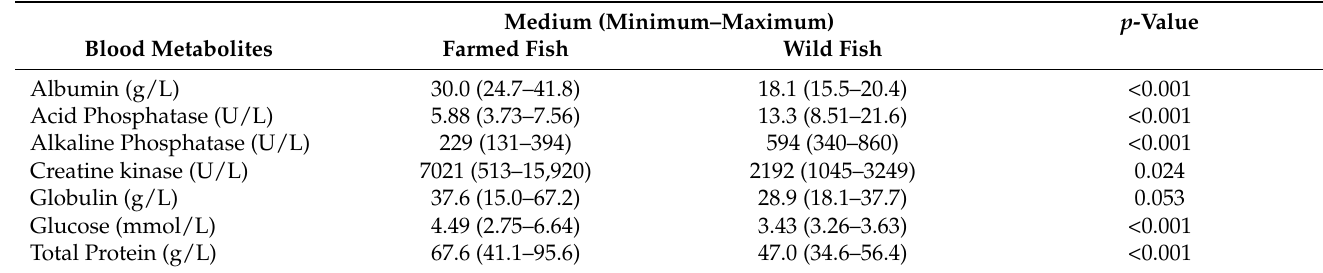
Table 1. Blood metabolites in rainbow trout ( Oncorhynchus mykiss ) from fresh water.